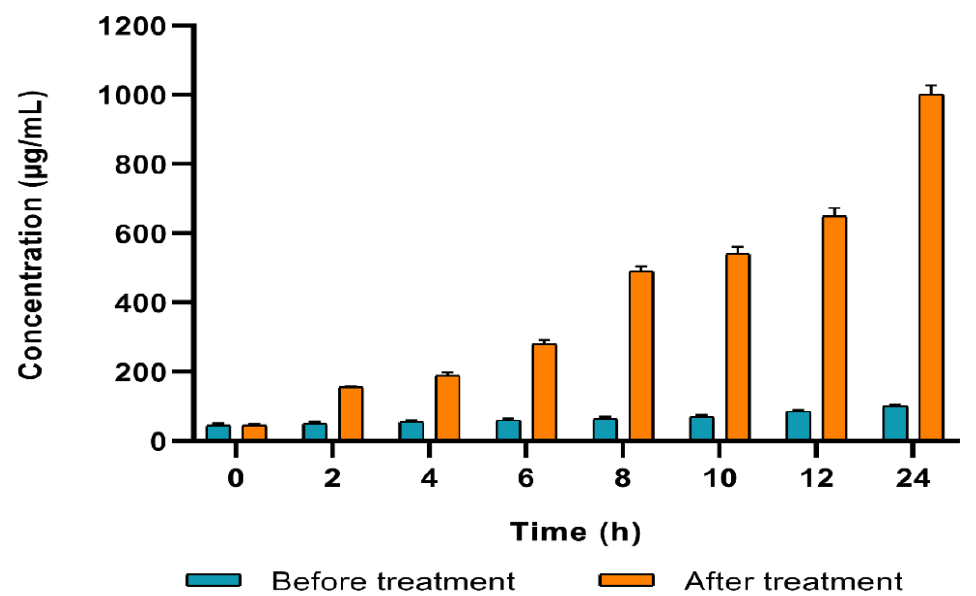
Figure 4. An illustrative example for the isolate (A1), showing a significant rise in the protein concentration after treatment with SAME.